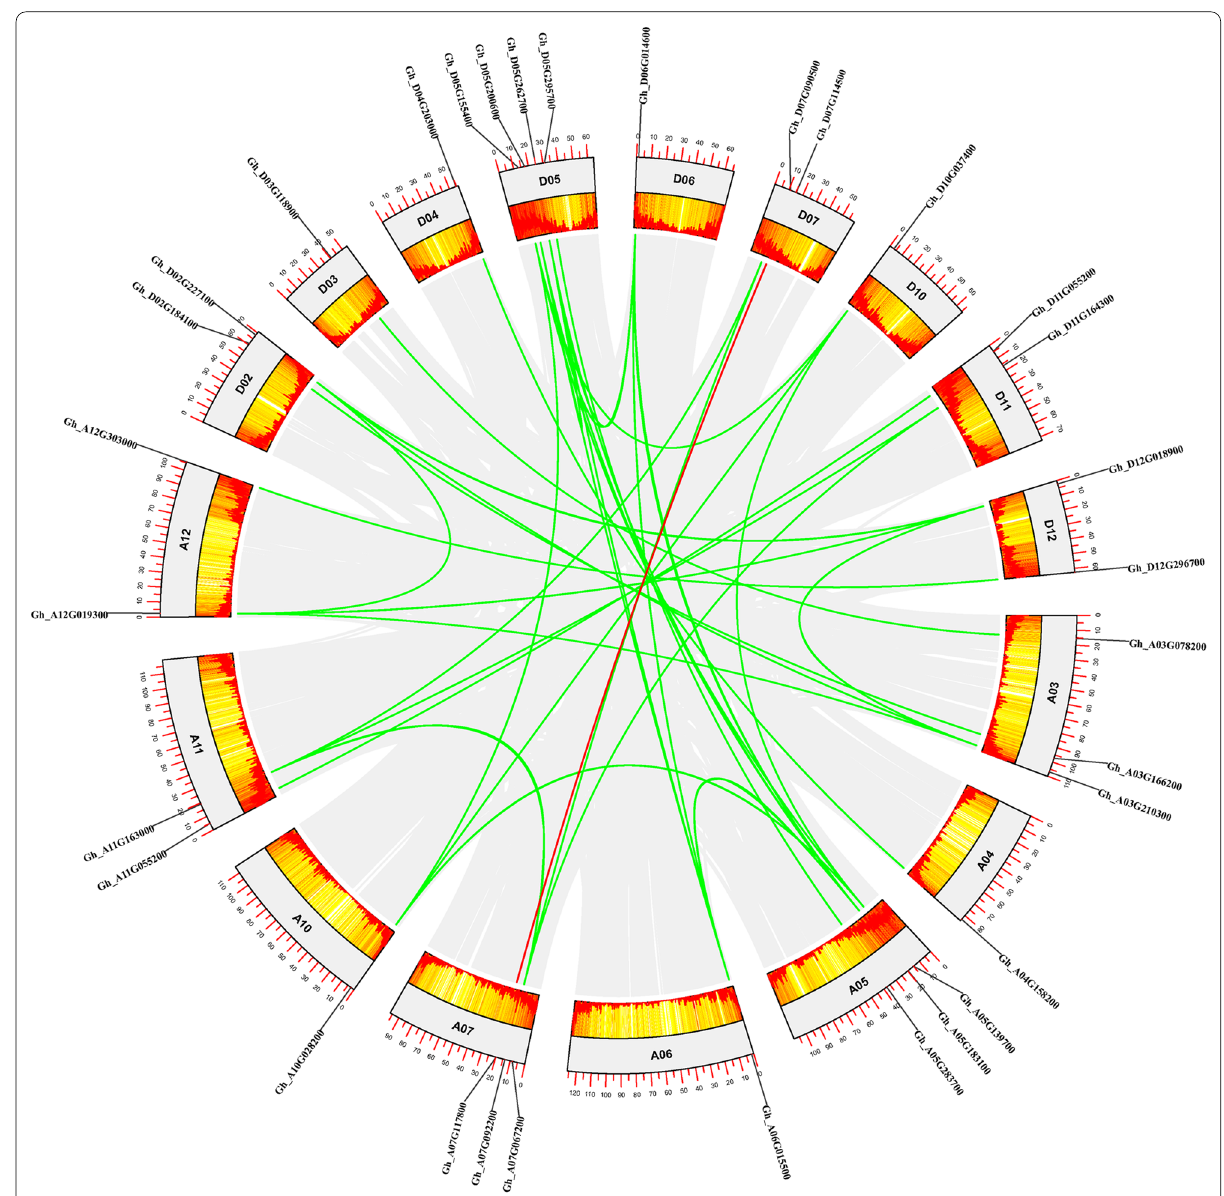
Fig. 3 Collinearity and gene duplication analysis of NAT genes in Gossypium